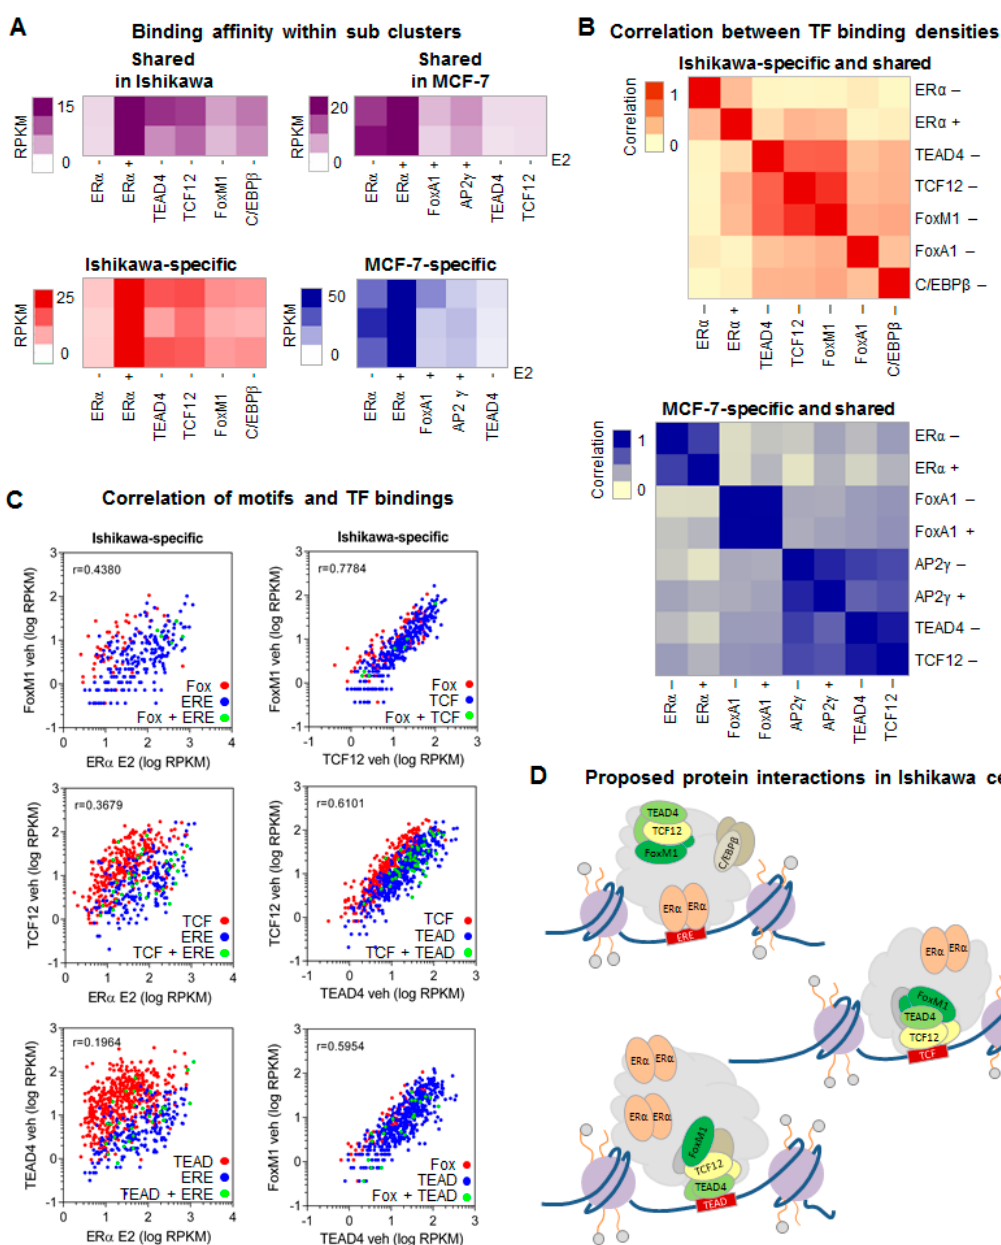
Figure 3. Response elements determine a consistent hierarchy between transcription factor binding events. ( A ) Heat maps depict the density of relevant TFs in the presence ( + ) or absence ( − ) of E2 within the same sub-clusters introduced in Figure 2C. The plotted densities are the averages of the values calculated by HOMER within 50-bp regions around the summit of the sub-clusters’ SE constituents. In the case of shared peaks, ChIP-seq coverages were separately calculated for both Ishikawa and MCF-7 cells. ( B ) Correlation plots showing the correlation coe ffi cients (r) calculated from the densities of all investigated TFs on the SE constituents (summit ± 50-bp regions) of Ishikawa and MCF-7 cells. ( C ) Scatter plots showing the densities of the indicated TFs (upon vehicle [veh] or E2 treatment) on their DNA binding motifs within the MCF-7- or Ishikawa-specific ER α -driven SE constituents. Red and blue dots represent protein binding on a specific single motif, and green dots represent protein binding on a region with the motifs of both examined TFs. ( D ) Working models of the supposed hierarchy between ER α , FoxM1, TCF12, and TEAD4 TFs in Ishikawa cells based on the presence of ERE, TCF, or TEAD response elements.